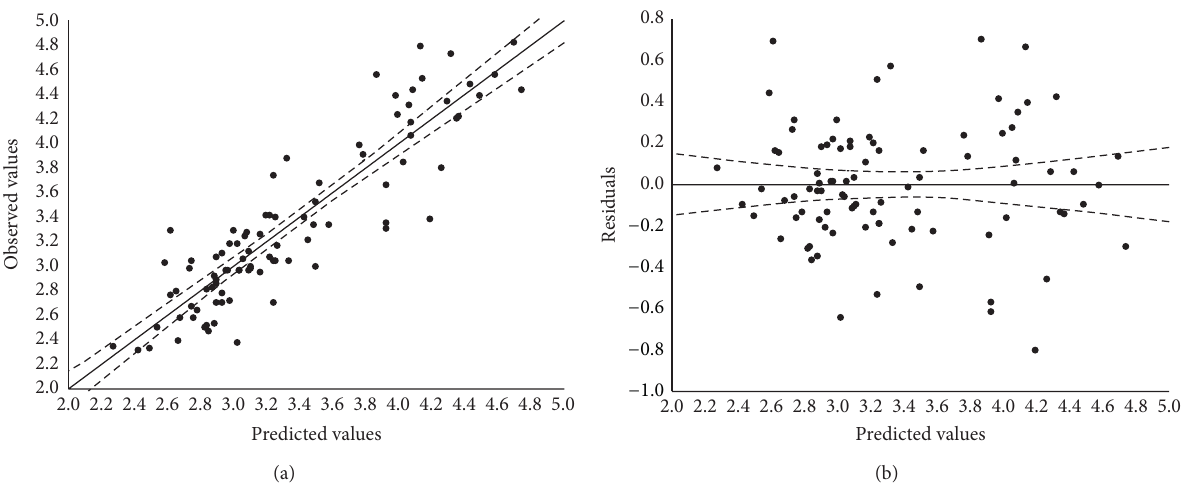
Figure 10: (a) Observed data in function of the predicted data for the adjusted equation; (b) distribution of residuals in function of the predicted data. P.S.: logarithmic data.